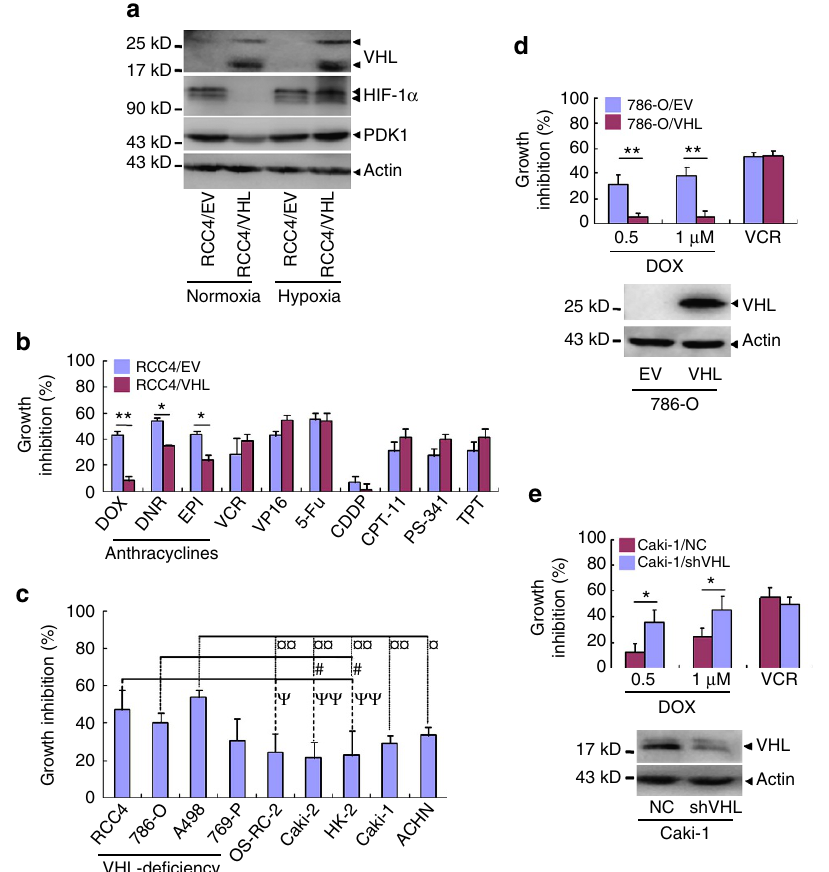
Figure 1 | VHL-deficiency augments the cytotoxicity of anthracyclines in ccRCC. ( a ) RCC4/EV and RCC4/VHL were incubated in normoxia or hypoxia for 24h and the indicated proteins expression was detected by western blot. ( b ) Different chemotherapeutic drugs were applied to treat RCC4/EVand RCC4/VHL cells for 24h and cell growth inhibition rates were detected by CCK-8. ( c ) Doxorubicin was used to treat different ccRCC cell lines for 24h and cell growth inhibition rates were detected and analysed using one-way ANOVA test followed by Bonferroni correction for post hoc test. c , # and , respectively, represent the difference of RCC4, 786-O and A498 versus OS-RC-2, Caki-2 , HK-2, Caki-1 or ACHN. ( c , # and , P o 0.05, cc and , P o 0.01). ( d , e ) Western blot for VHL with actin as a loading control (bottom) and cell growth inhibition rates after treatment with doxorubicin or 1 m M VCR for 24h (Top). ( d ) 786-O cells were stably transfected with VHL expression vector (VHL) or EV. ( e ) Caki-1 cells were infected with retroviral vectors harbouring shRNAs against VHL (shVHL) or NC. The column represents mean with bar as s.d. of three independent experiments with triplicate samples. ( *P o 0.05,** P o 0.01 for t -test). ANOVA, analysis of variance; EPI, epirubicin; EV, empty vector; CDDP, cis-Diaminedichloroplatinum; CPT-11, irinotecan; DOX, doxorubicin and; DNR, daunomycin; 5-Fu, fluorouracil; NC, non-specific control; PS-341, bortezomib; TPT, topotecan; VCR, vincristine; VP-16, vepeside. NATURE COMMUNICATIONS|8:15337|DOI: